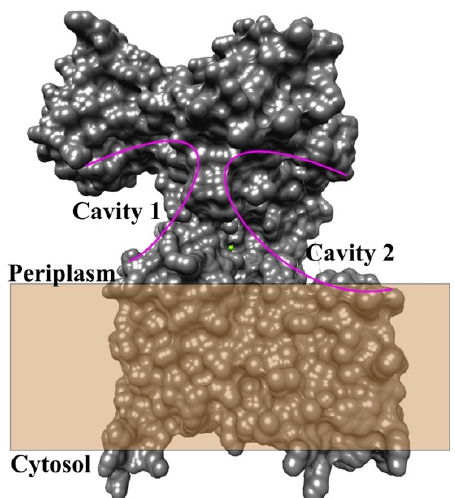
Figure 3. Surface representation of the bacterial PglB protein displays two cavities right above the membrane. The cavities are highlighted by purple solid arcs. The figure was prepared with chimera software and PDB file 3RCE.